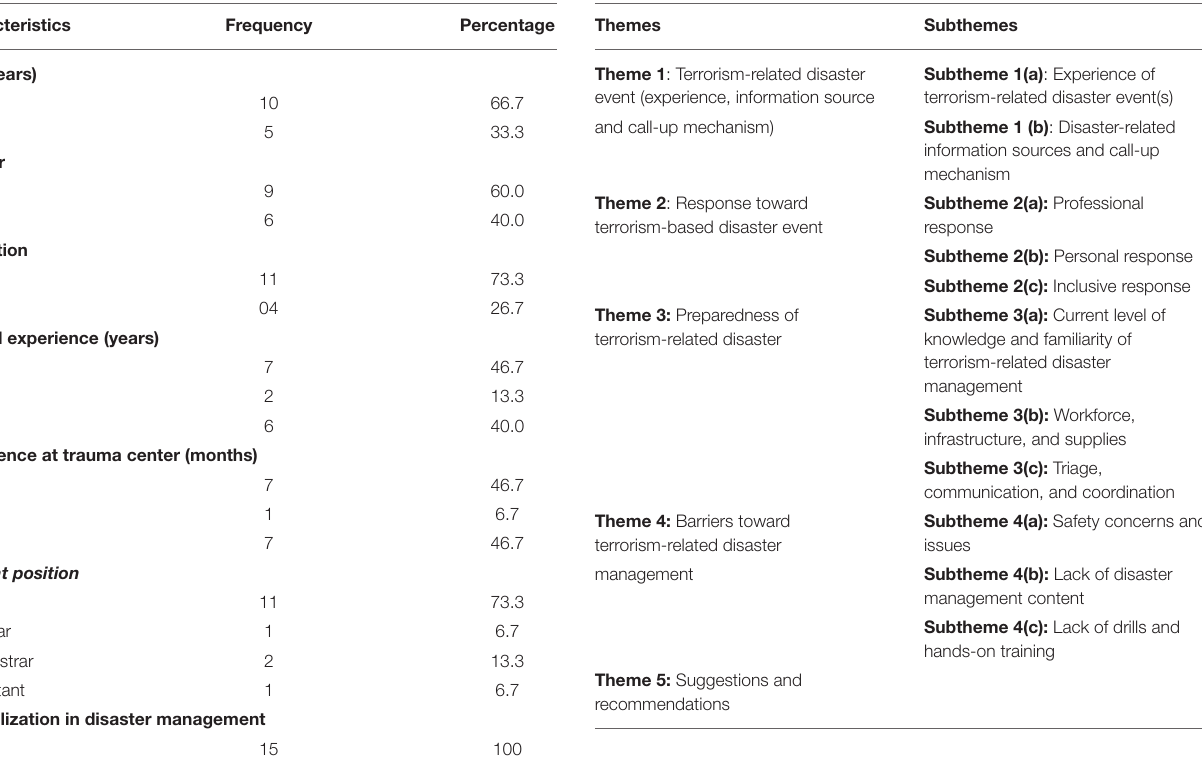
TABLE 2 | Themes and subthemes identified during data